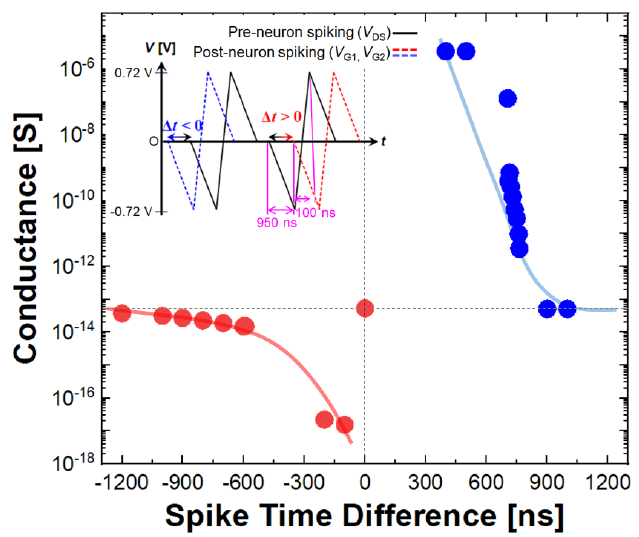
Figure 7. Spike-timing-dependent plasticity characteristic of the proposed synaptic device. The inset describes the potentiation and depression pulse schemes.